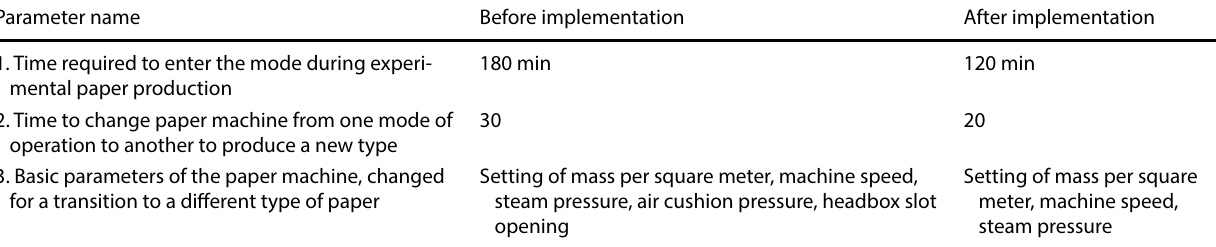
Table 1 Evaluation of the effectiveness of automated control system for the technological process of paper production Parameter